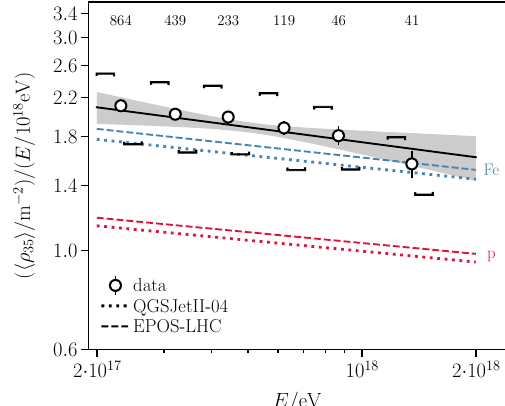
Fig. 11 Energy-normalized muon densities (cid:14) ρ 35 (cid:15) /( E / 10 18 eV ) as a function of E compared to expectations from simulations using EPOS- LHC (dashed) and QGSJetII- 04 (dotted). Errorbars denotethestatisti- cal uncertainties, while systematic uncertainties are indicated by square